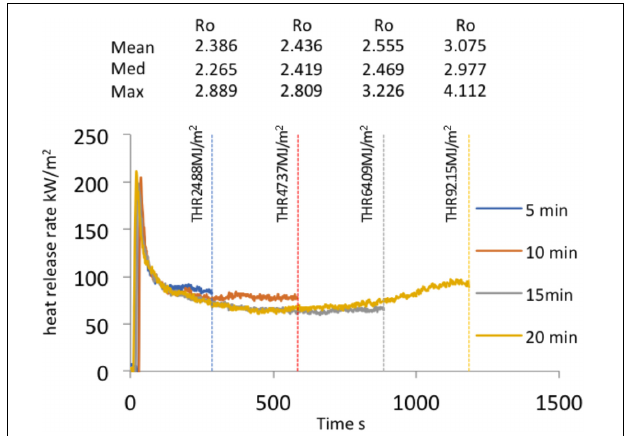
FIGURE 2 | Summary overview of heat release rate profiles, total heat release and the range of surface Ro% generated during flaming combustion tests of WRC. Blue line flaming for 5 min, orange line 10 min, gray line 15 min, and yellow line 20